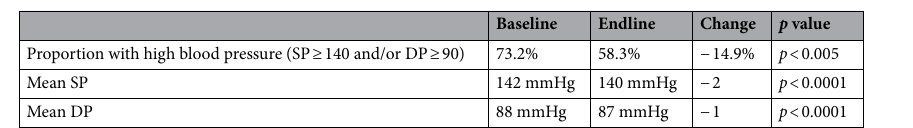
Table 4. Change in blood pressure from baseline to last visit (n = 11,877). DP diastolic pressure, SP systolic pressure.